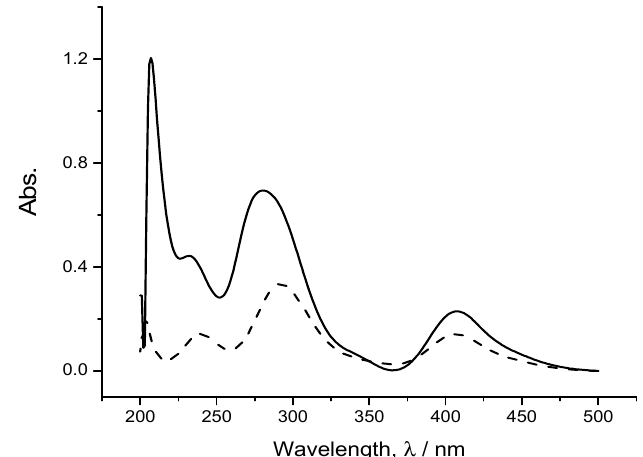
Figure 4. UV-Vis spectra of a dissolved metallic copper disc (solid line) at 50 mA · cm − 2 for 1 h at ambient temperature and 0.1 mM (CuCl 2 ) · 2H 2 O (dash line) in 1:2EG:ChCl electrolyte (choline chloride-based IL) on a platinum electrode.